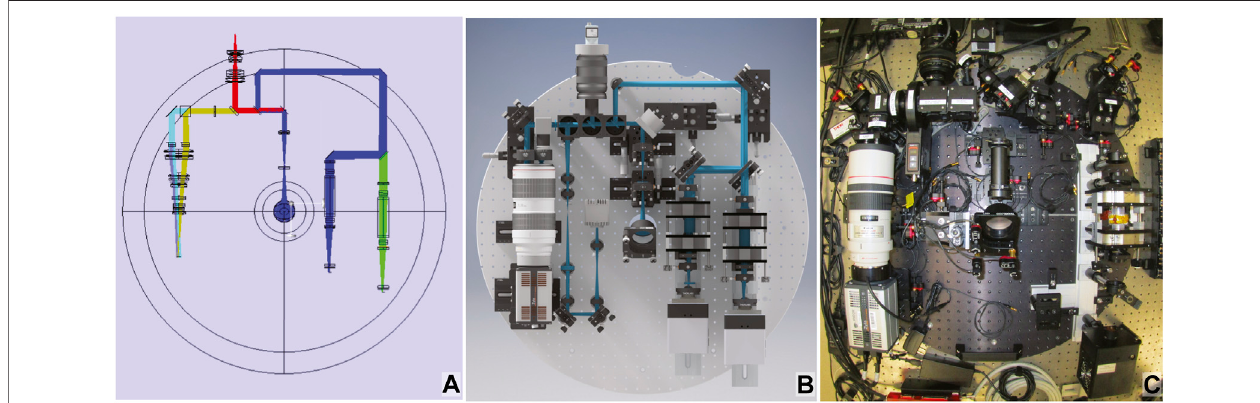
FIGURE 4 | (A) : A Zemax model of the complete LANDIT (the South Pole version of PMODE) focal plane instrument suite. (B) : a rendered CAD drawing of the LANDIT instrument suite. The left side of the path containsthe polarimeter, tracker, and wavefront sensor.The right side of the path containsthe sodium and potassium MOFchannels. (C) :TheactualsystemasofJuly2019.Here,onechannelismissingfromtheDopplerimager.NophotographswerecollectedofthecompletedPMODE instrument, so we provide these of her sister instrument, for